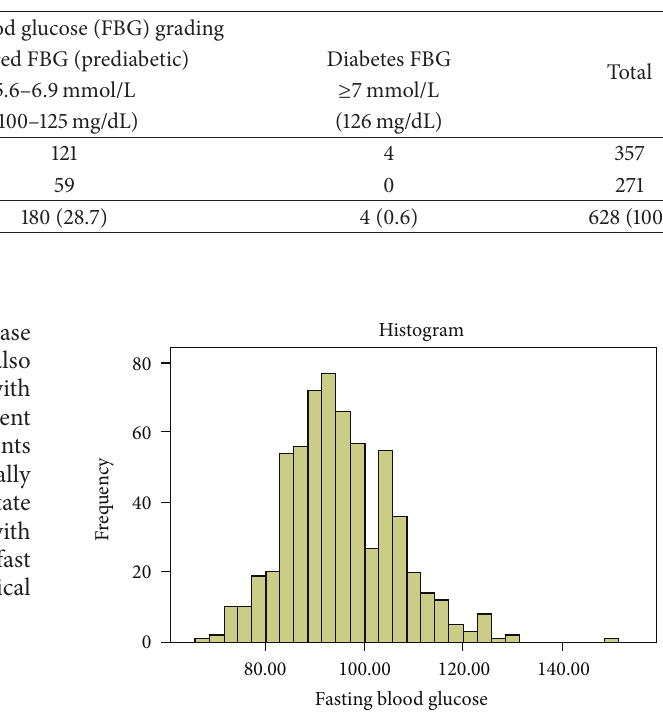
Table 1: Fasting blood glucose grading according to age group.